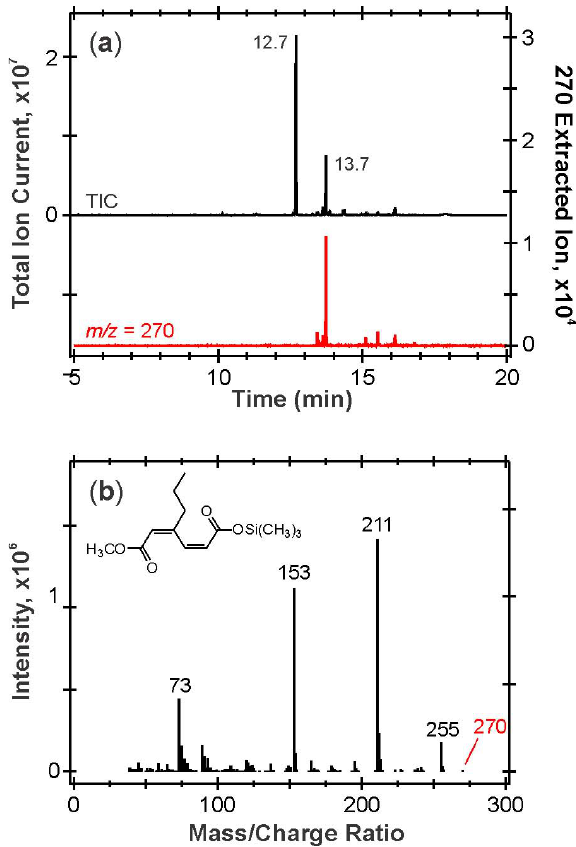
Fig. 4. (a) Total ion current gas chromatogram (black) and m/z = 270 extracted ion chromatogram (red) of products extracted from 4- propylguaiacol ozonolysis sample. (b) Mass spectrum of 13.7min peak assigned as ring-cleaved